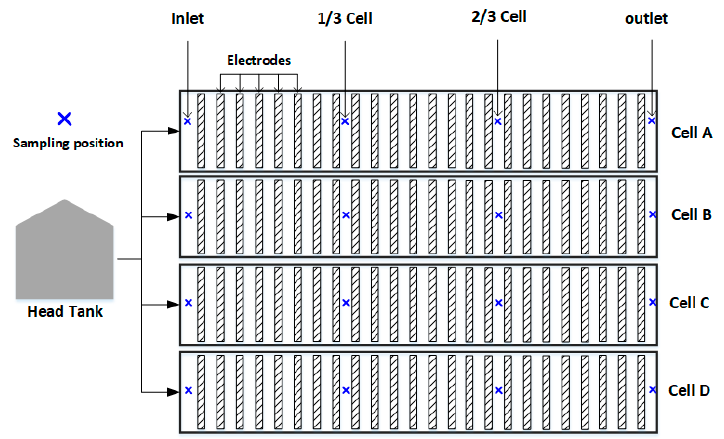
Figure 1. Schematic illustration of cells in the tank house, and the in situ conductivity measurements and sampling points. Table 2. Composition of industrial electrolytes obtained from Boliden Odda Zinc Smelter.